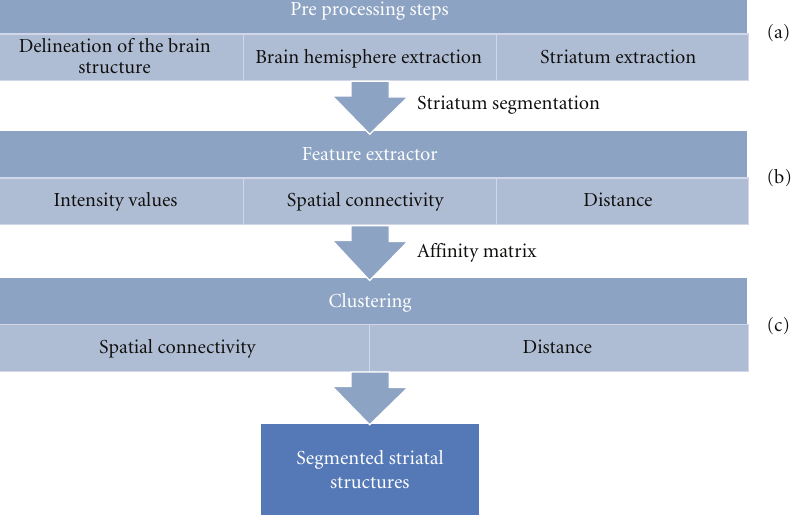
Figure 2: Steps of the segmentation of caudate, putamen, and ventral striatum: (a) preprocessing steps, (b) a ffi nity matrix construction method, (c) clustering process.